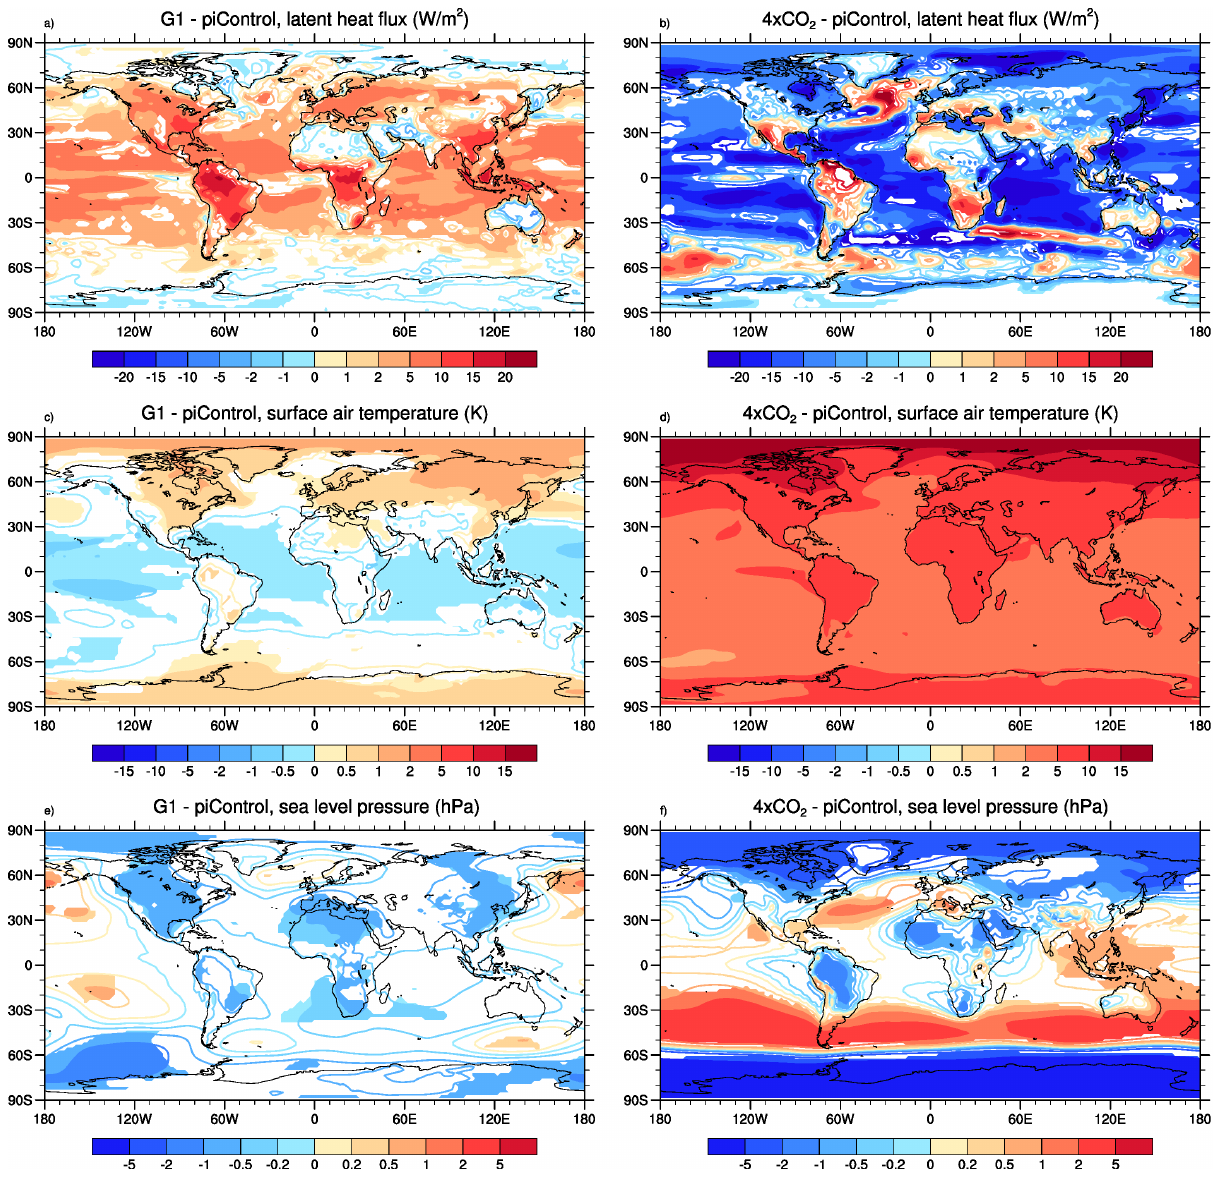
Fig. 3. Differences between the simulations G1 and piControl (left), and abrupt4xCO2 and piControl (right), averaged over the four ESMs. Top panels: surface latent heat flux (Wm − 2 ; defined as positive downward), middle panels: near surface air temperature (K), and bottom panels: sea level pressure (hPa). In regions with filled color shading all models agree in the sign of the response. The value represented by the contours is given by the upper edge of the respective range in the color bar, i.e. the zero line is colored light